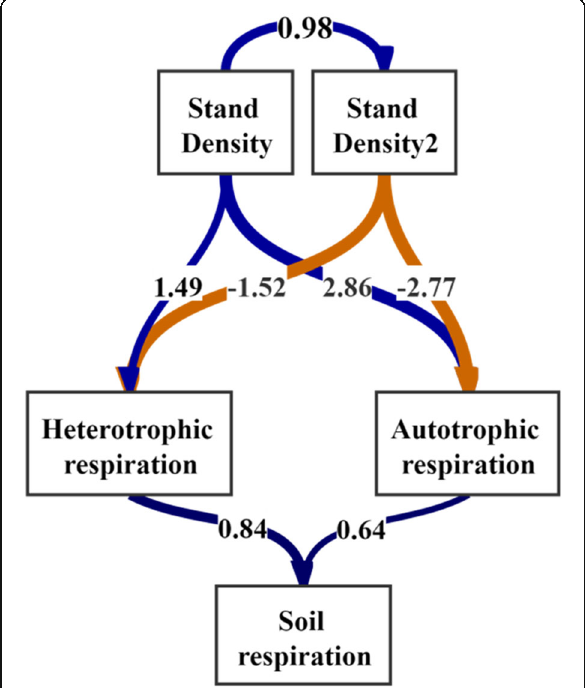
Fig. 4 Structural equation model of the influencing mechanism of stand density on Rh, Ra, and Rs. Stand density 2 is the square of the stand density; all lines are direct effects, the brown line is a negative effect, and the blue line is a positive effect. Note: according to previous results, it was found that the relationship between soil respiration and forest density was not a simple linear relationship. Therefore, the stand density square was introduced to construct a structural equation model, which made the model more